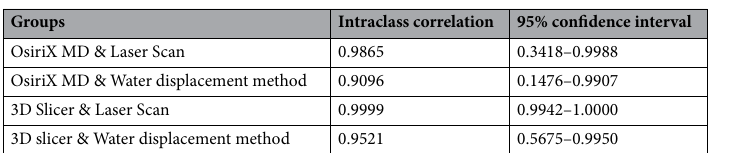
Table 4. In vitro validation. Intraclass correlation coefficient between